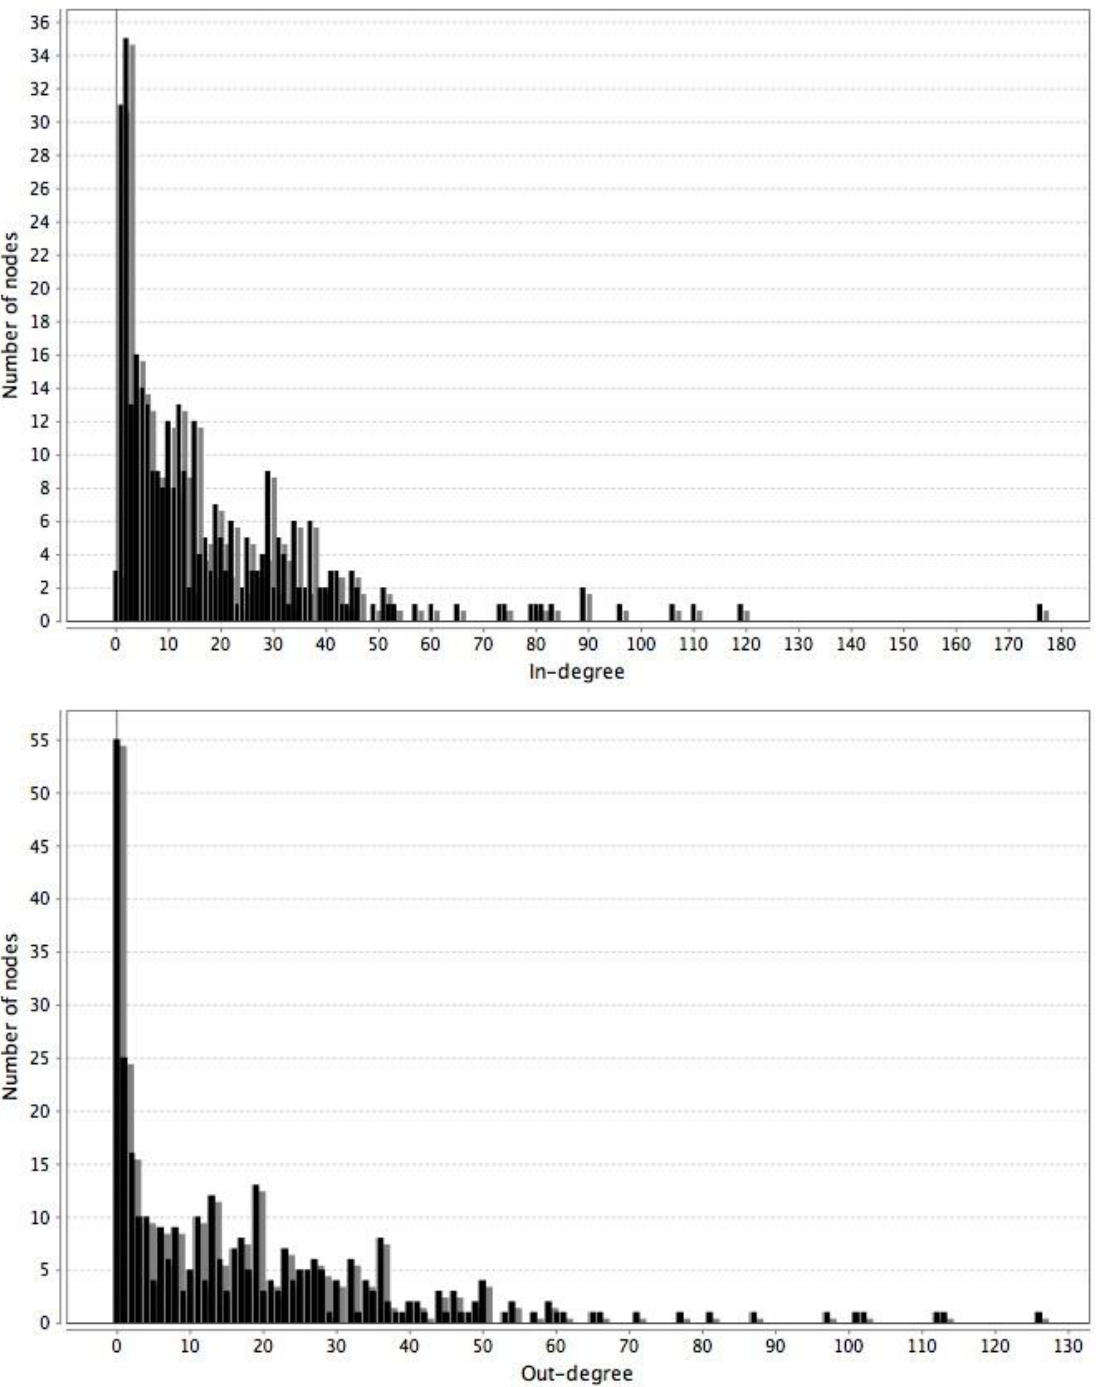
Figure 4 . In-degree (A) and out-degree (B) distribution of all the members in the general conversational